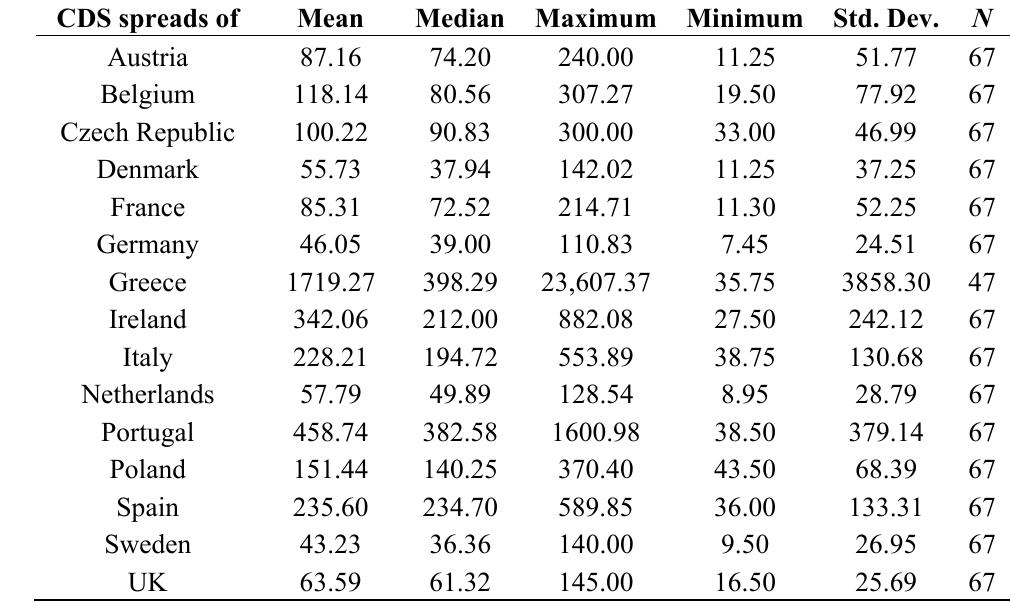
Table A3. Descriptive Statistics of the Dependent